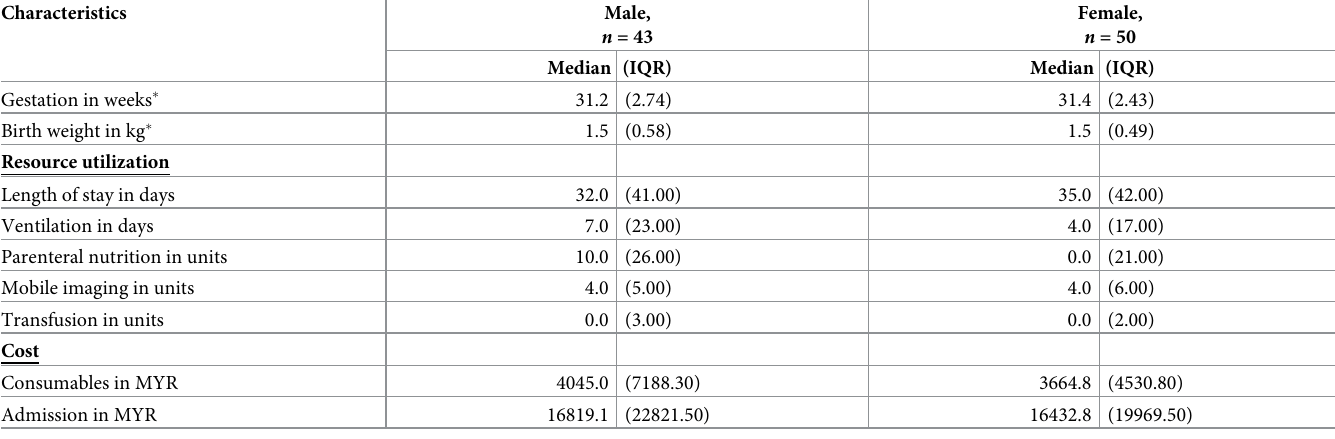
Table 5. Gender comparison (intensive